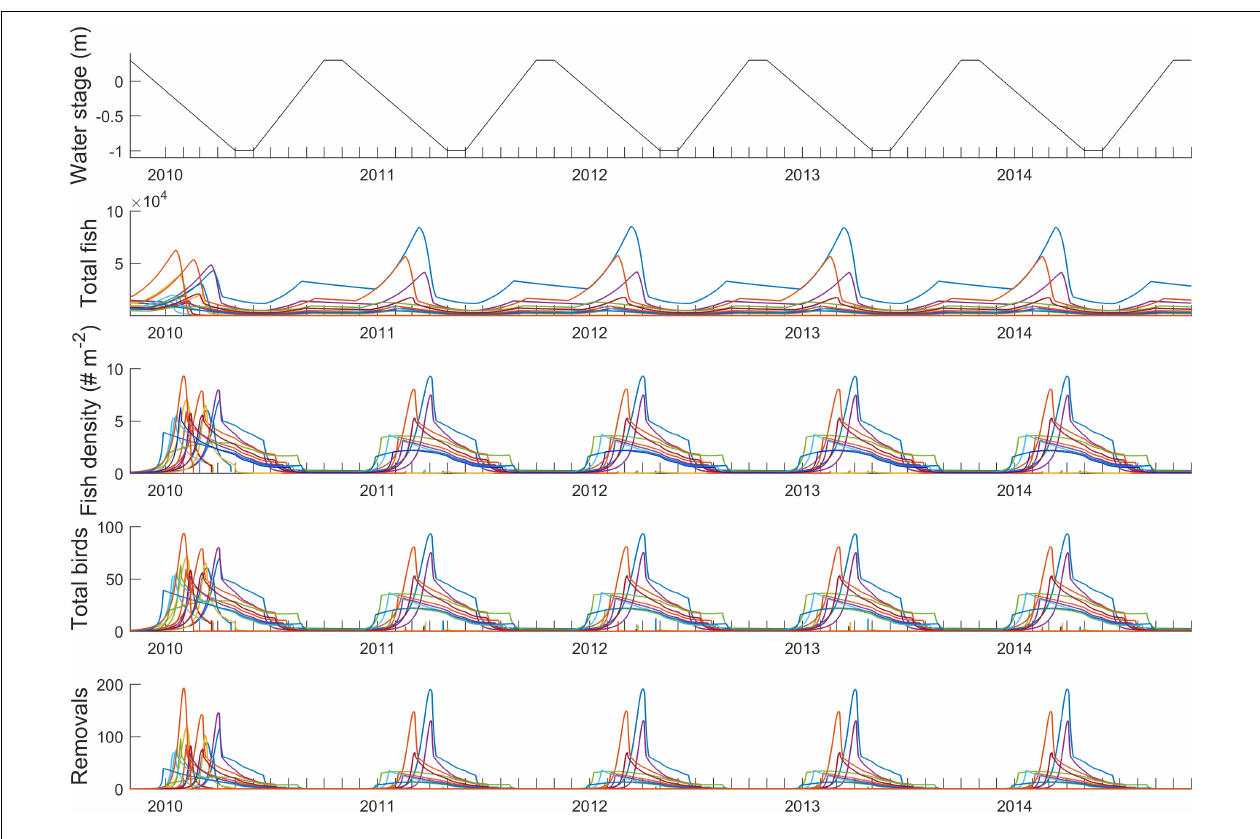
FIGURE 5 | Predator-prey-landscape system modeled through